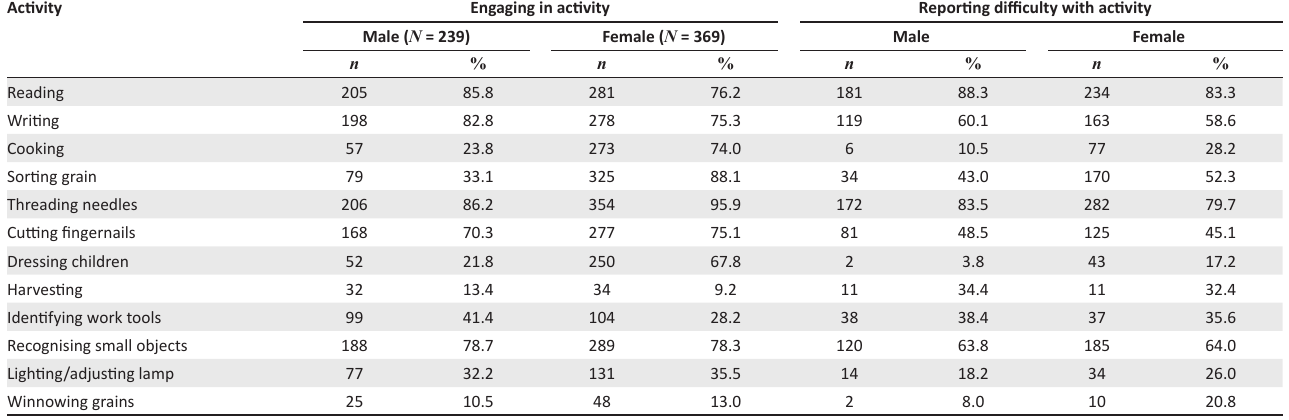
TABLE 4: Those reporting engaging in and having difficulty with near-vision-related tasks. Activity